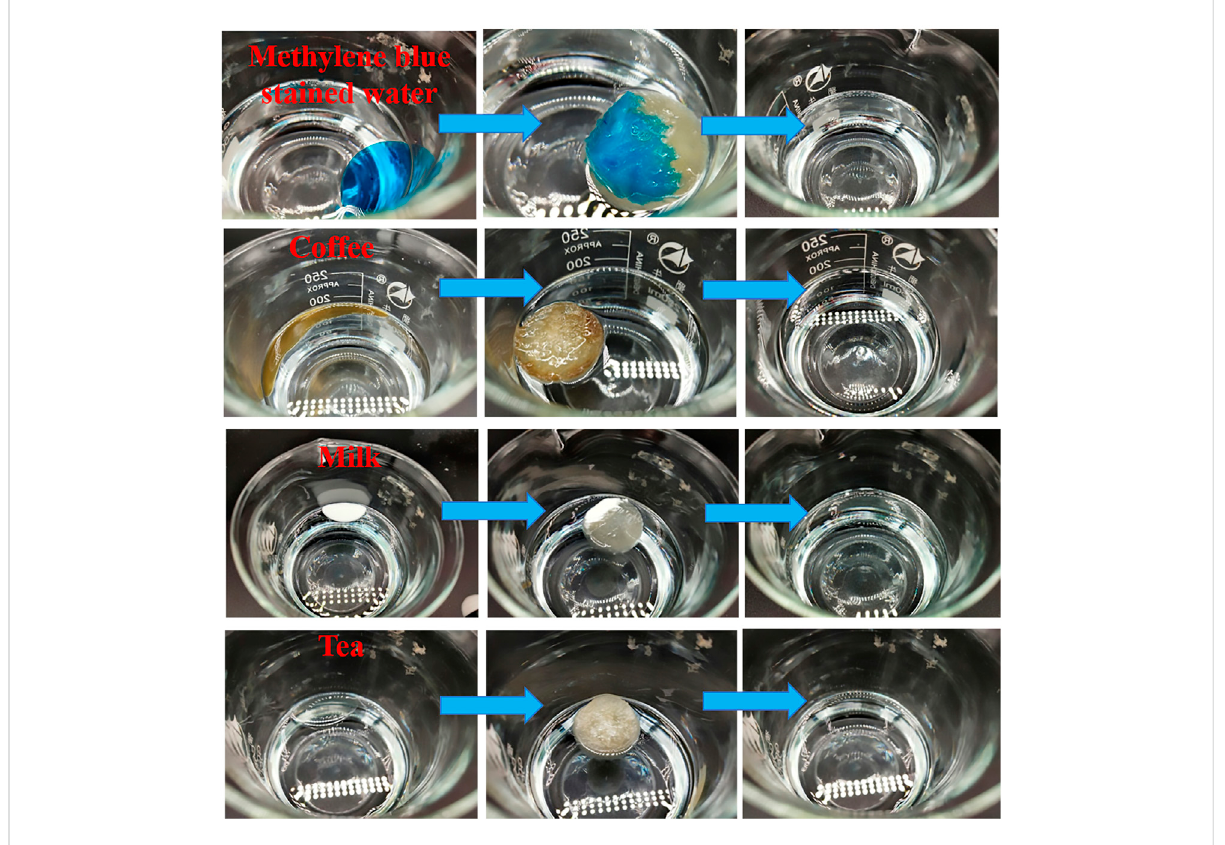
FIGURE 8 Impurities on the liquids in chloroform by the adsorption of water-saturated